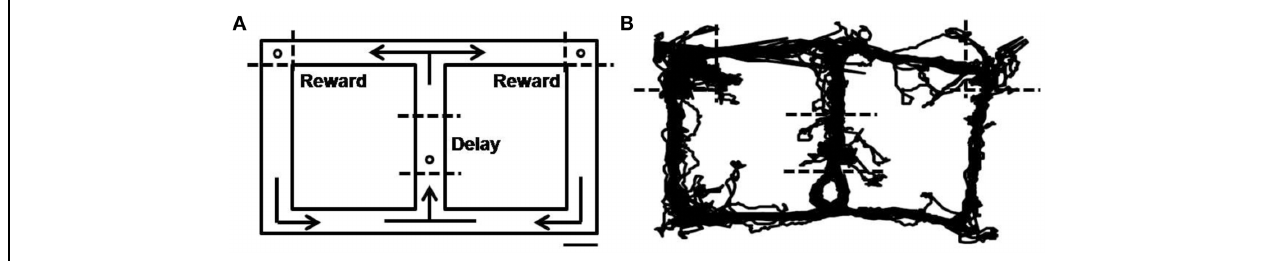
were also rewarded with water (20 μ l) on the central stem (open circle) in all trials. Dashed lines denote approximate boundaries for the delay and reward periods, and arrows indicate movement directions. Scale bar, 10cm. (B) An example of rat’s movement trajectory in one behavioral